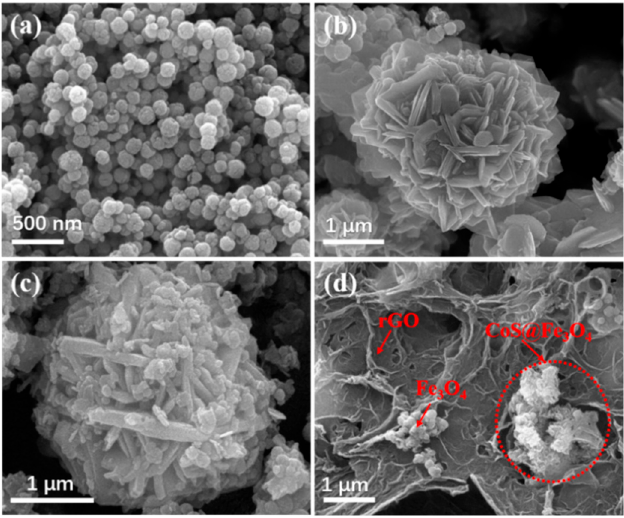
Figure 2. X-ray photoelectron spectroscopy (XPS) spectra of CoS@Fe 3 O 4 @rGO: ( a ) Fe 2p, ( b ) O 1s, ( c ) 1s, ( d ) Co 2p, and ( e ) S 2p. C 1s, ( d ) Co 2p, and ( e ) S 2p.